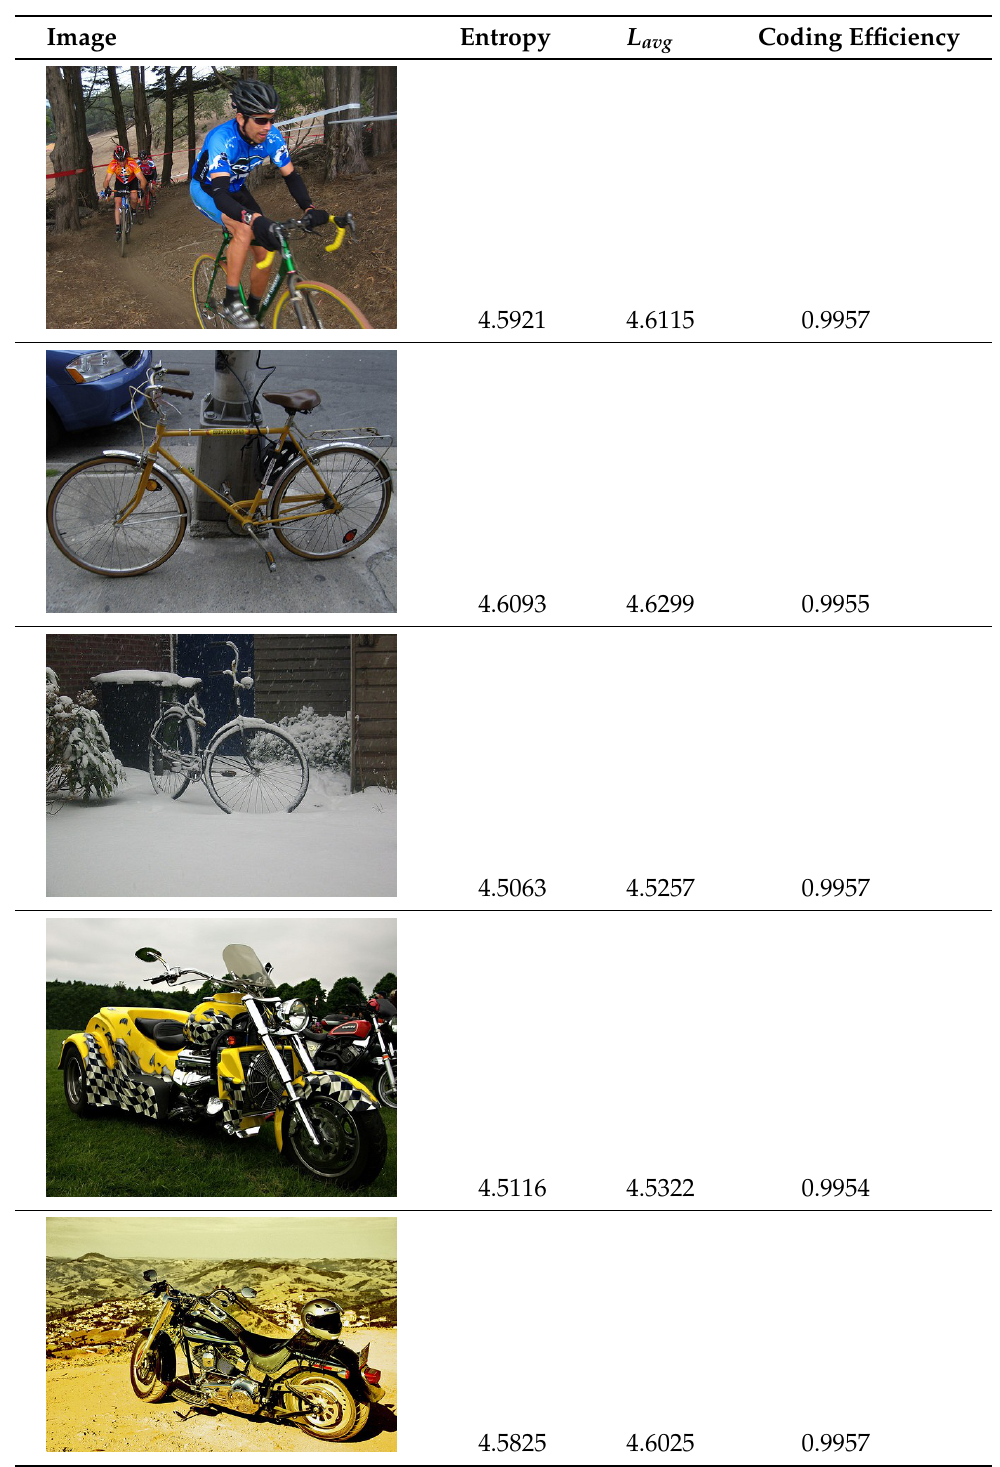
Table 10. The Huffman coding